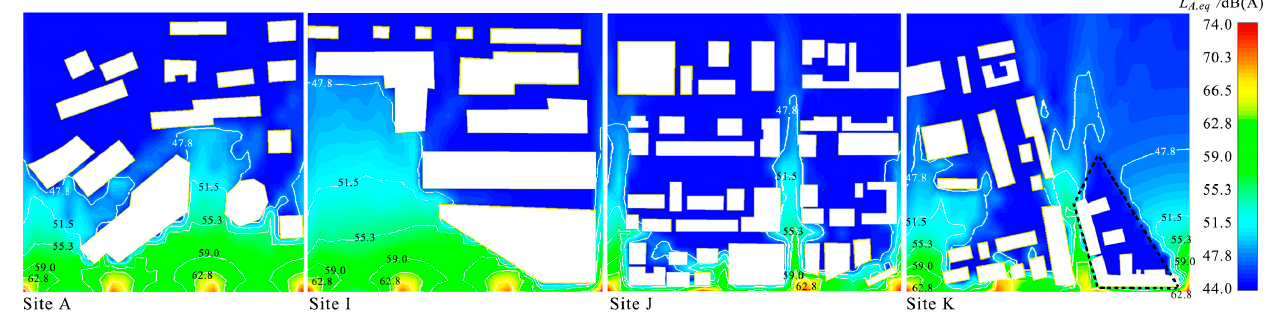
Figure 6. Area exposure proportions of noise levels, L A,eq , for the fifteen sites under different num- bers of air filters (( a ) two air filters; ( b ) four air filters; ( c ) six air filters). Figure 7. Noise exposure maps in open areas 1.2 m above the ground with four air filters in Sites A, I, J, and K (the dotted line in Site K represents the shadow zone created by the resistance effect of buildings).